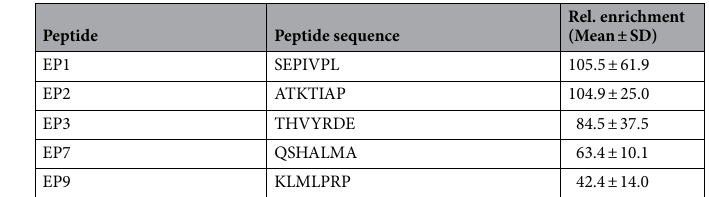
Table 1. EpiSC-specific peptides (EP): lead peptides selected from the pool of peptide sequences obtained from the second round of the biopanning procedure. Displayed is the number of the peptide (EP), the peptide sequence and the mean relative enrichment (± SD) compared to the parent phage